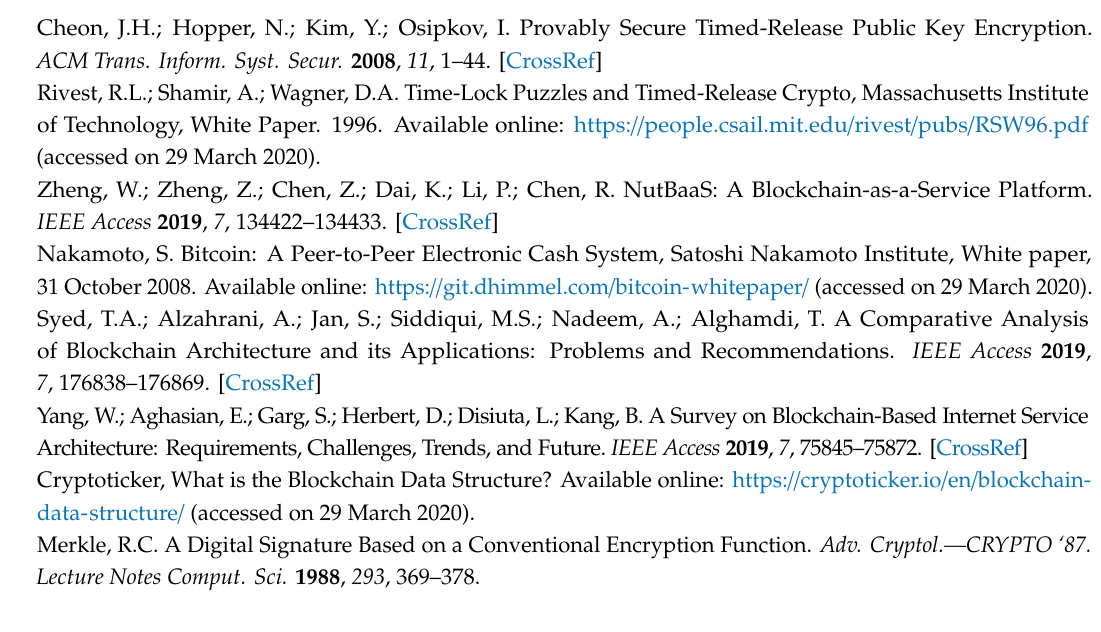
Forgiveness O Admin